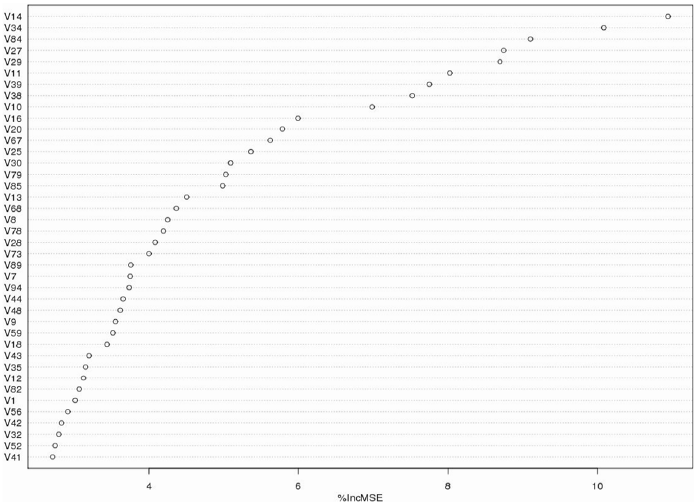
Fig 2. Top-ranking features useful for protein binding hot spot prediction by random forest. ‘ % IncMSE ’ indicates the increase of the mean standard error (MSE) after the permutation of the features. The definitions of the top 25 important features are listed in Table